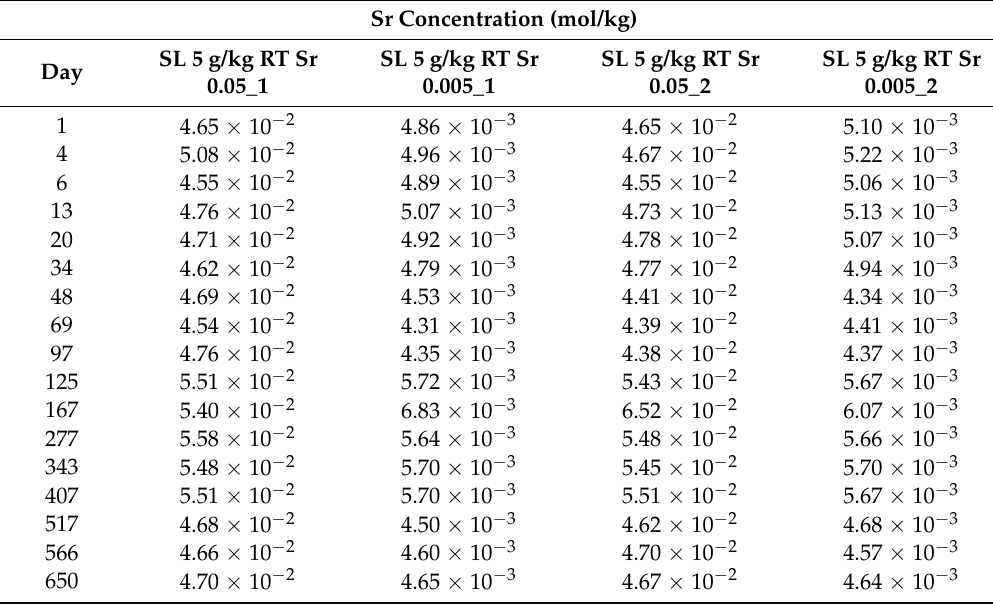
Table A11. Sr concentration of experiments with Sr in the aqueous solution at 23 ◦